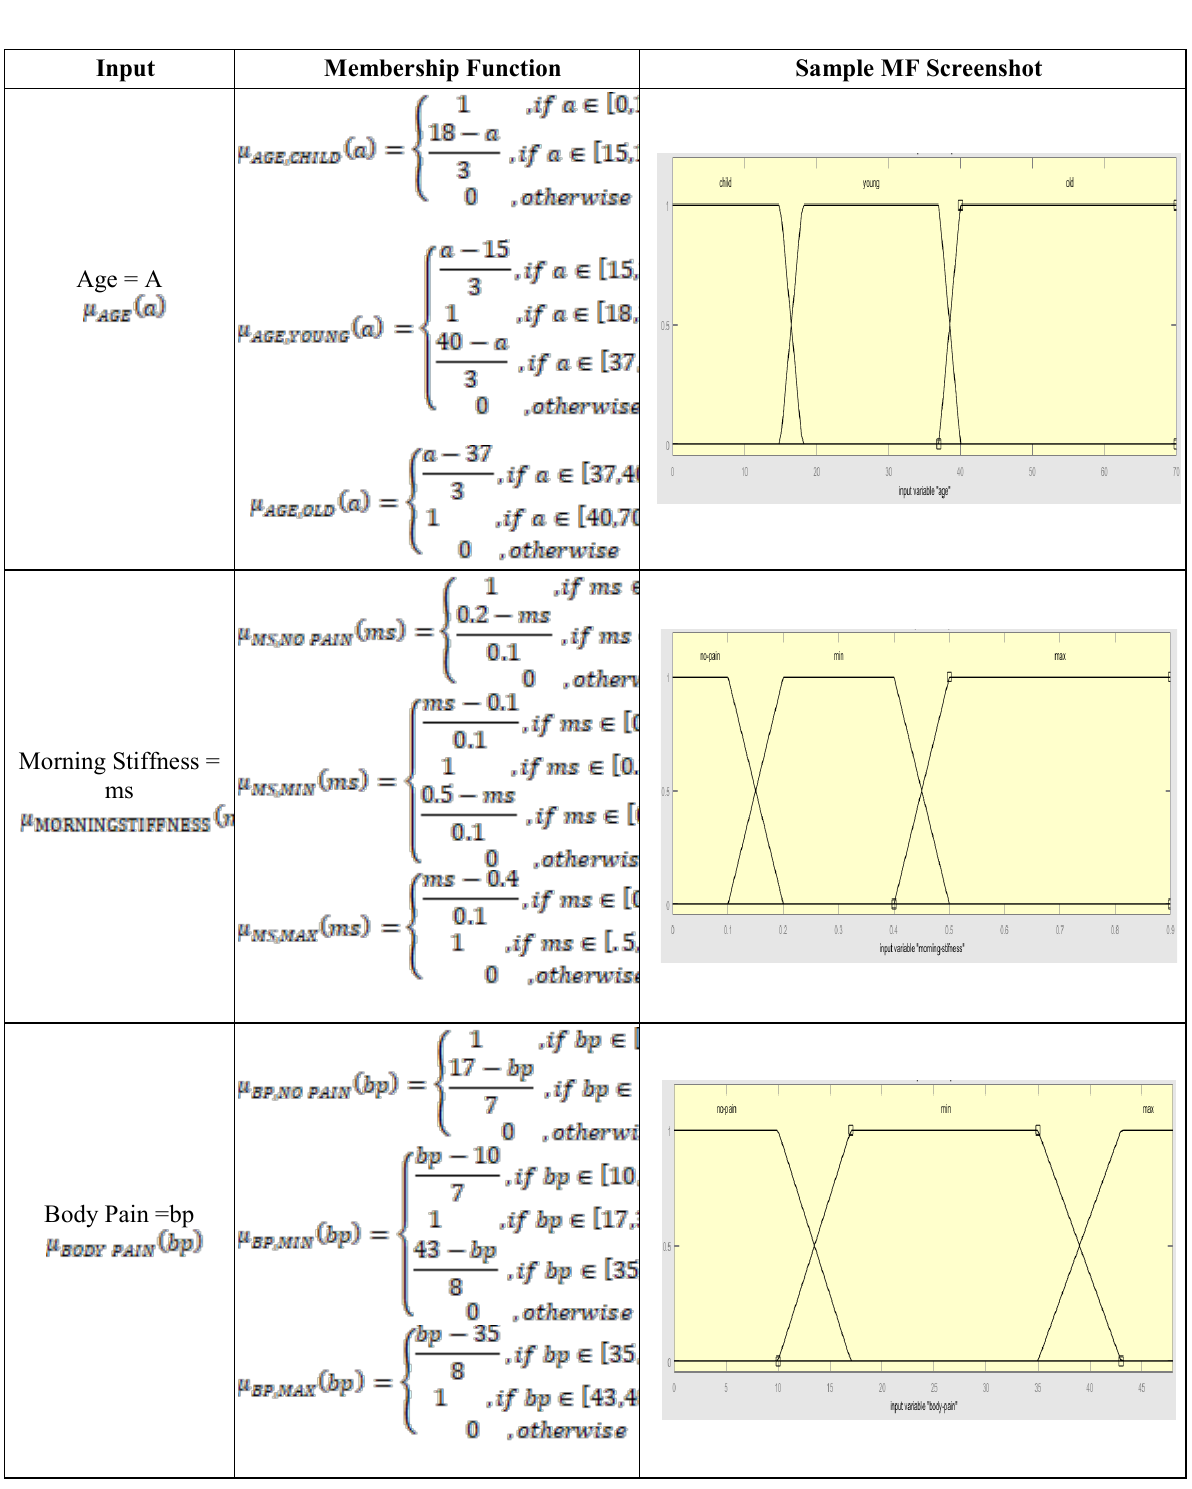
Table 4. Mathematical & Graphical MF of Layer-1 Mamdani Fuzzy Inference System Input